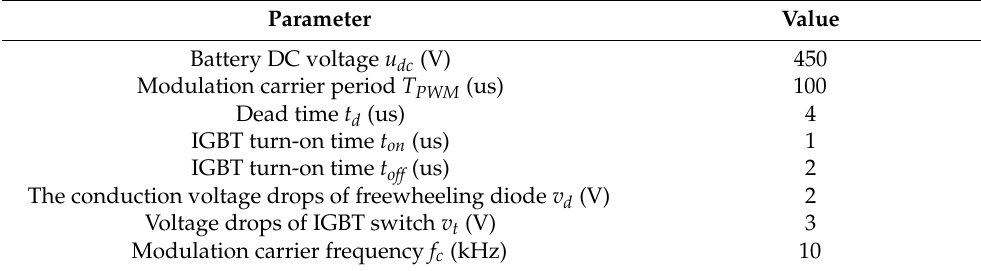
Table 2. Permanents of the